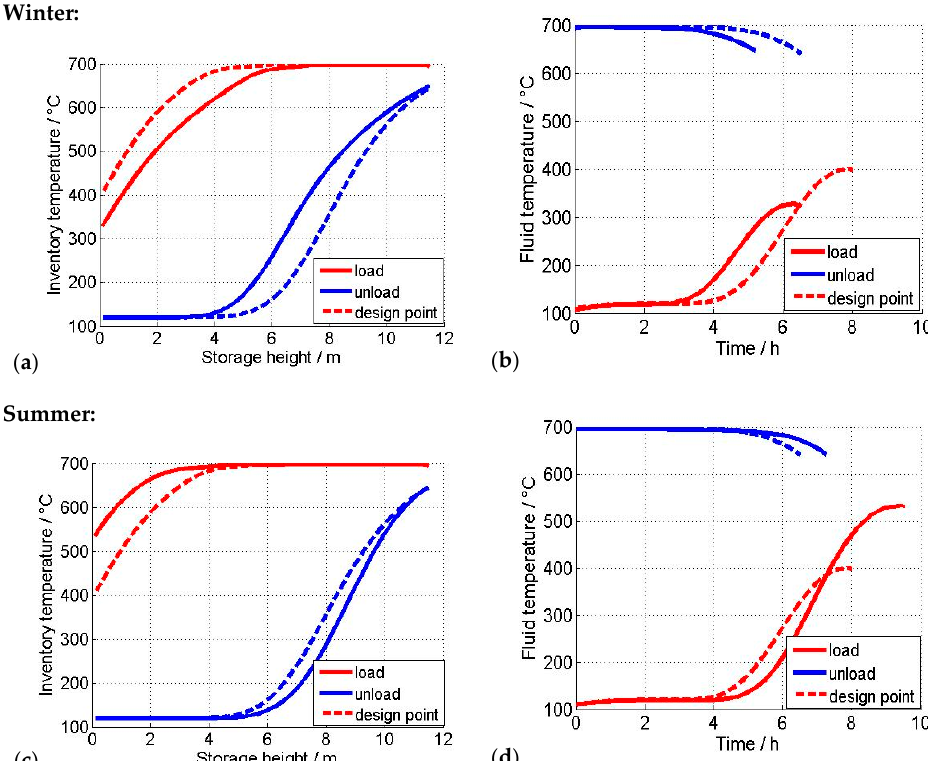
Figure 8. Winter and summer behavior: ( a ) Winter: Temperature profiles of the inventory versus the storage height at the end of the charging and discharging process, ( b ) Winter: Fluid outlet temperature during the charging and discharging process, ( c ) Summer: Temperature profiles of the inventory versus the storage height at the end of the charging and discharging process, ( d ) Summer: Fluid outlet temperature during the charging and discharging process.